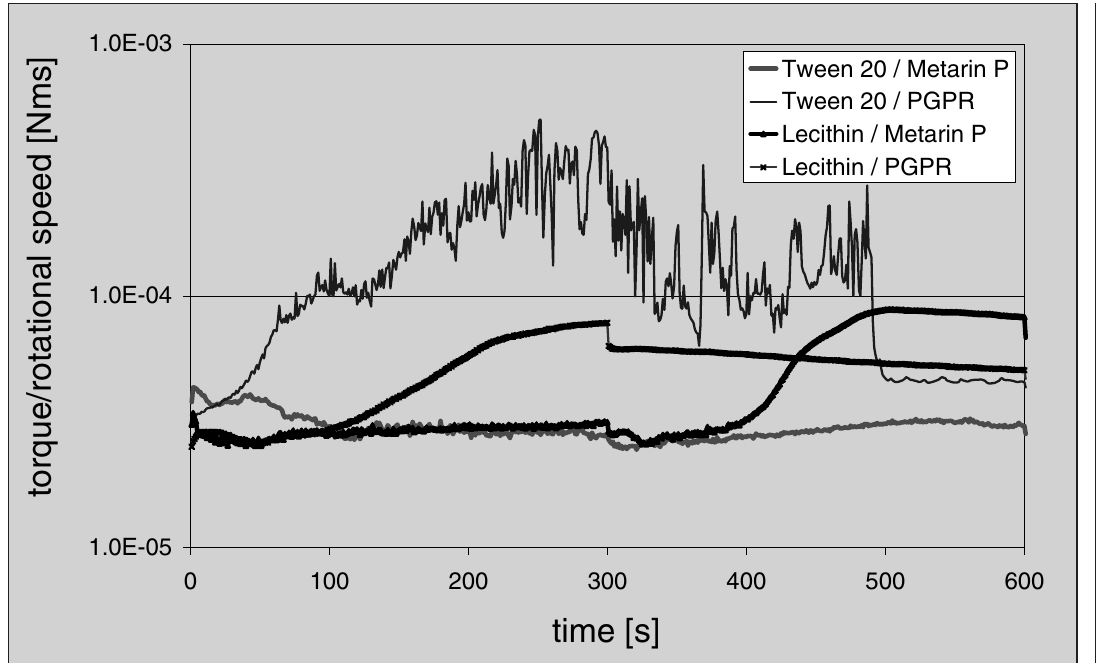
Figure 5: Viscosity progression for mixtures of hydrophilic 10% glass sphere suspensions containing Tween 20 or Sternpur PM with w/o emulsions containing PGPR or Metarin P (0-300s: 0.48 rev/s; 300-600s: 0.96